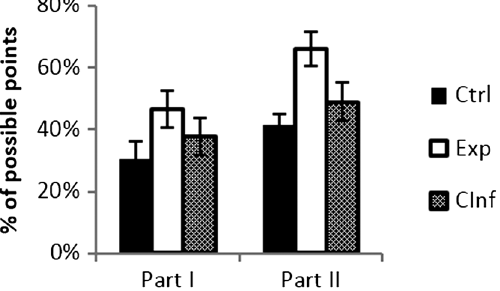
FIG. 11. Average post-test score for both parts of the post-test. Post-test scores are reported as the percentage of total available points earned.